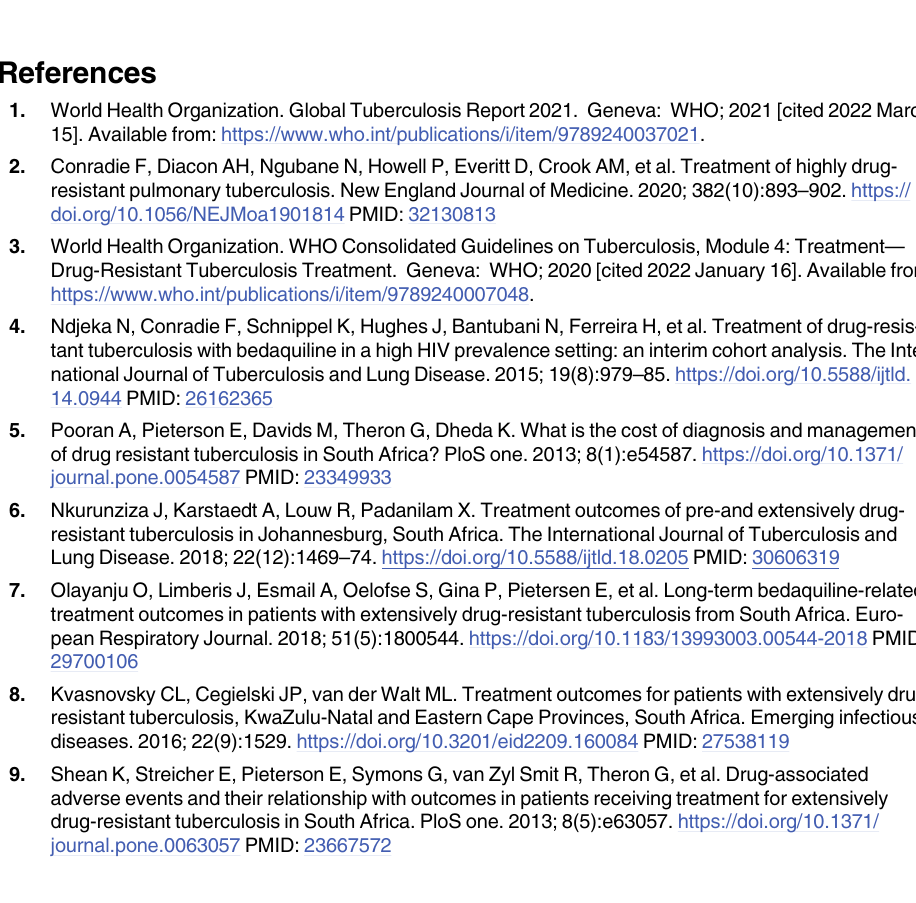
S1 Table. The drugs and dosages of the BDQ-based regimen and injectable-based regimen for the XDR-TB treatment. BDQ: Bedaquiline; XDR-TB: Extensively drug resistant tubercu-